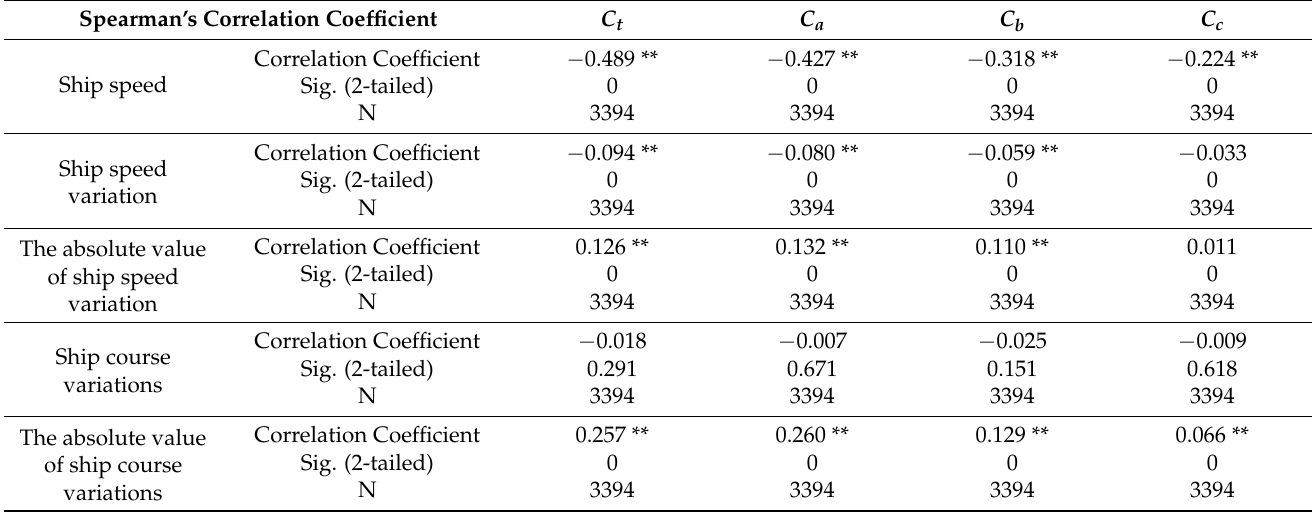
Table 4. The correlation coefficient between sea ice concentration and ship movement characteristics.